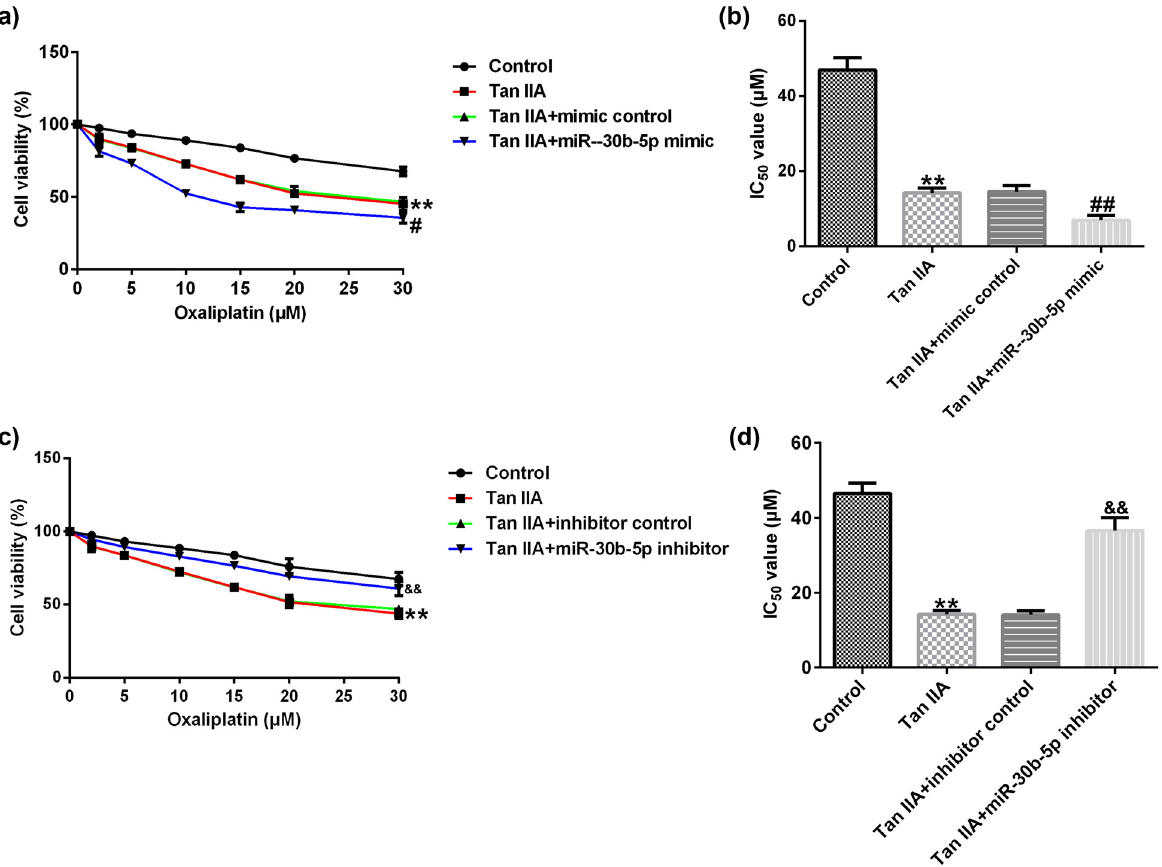
Figure 8: miR - 30b - 5p promotes the chemosensitivity of oxaliplatin induced by Tan IIA. ( a ) The SW480/R cell viability was detected by MTT assay with di ff erent concentrations of oxaliplatin stimulated after Tan IIA treatment and miR - 30b - 3p mimic transfection. ( b ) IC 50 value of SW480/R cells. ( c ) MTT assay was carried out to assess cell viability of SW480/R with di ff erent concentrations of oxaliplatin stimulated after Tan IIA treatment and miR - 30b - 3p inhibitor transfection. ( d ) IC 50 of SW480/R cells. Data are represented as the mean value ± SD of three independent experiments. ** P < 0.01 vs control group; #, ## P < 0.05, 0.01 vs Tan IIA + mimic control group; && P < 0.01 vs Tan IIA + inhibitor control